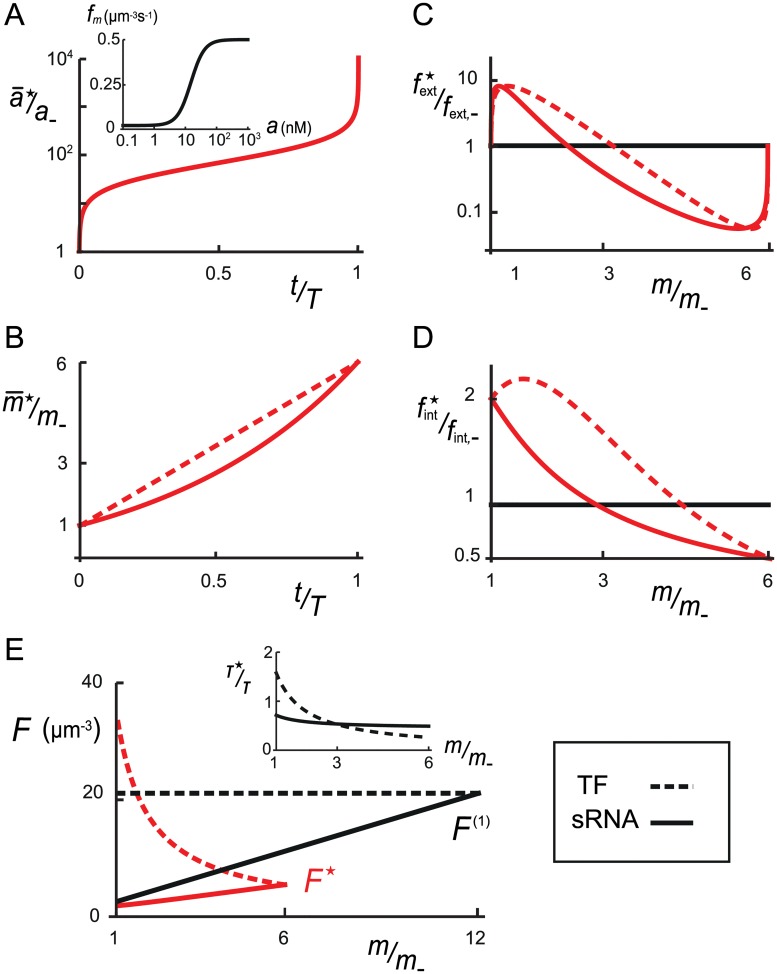
Optimal quorum-sensing response.TF regulation is shown by dashed curves and sRNA regulation by solid curves. A. The bare MP expression rate fm(1)(c), in the absence of self-regulation of the MP, obeys a Hill function with h = 2 (inset). Temporal dynamics of the optimal mean AI concentration and B. temporal dynamics of the optimal mean MP abundance. C. Optimal external feedback fext⋆ with f
− = a
−/(τ
a
ρ
−) and D. optimal internal feedback fint⋆. E. Fano function with optimal feedback F
⋆ and without feedback F as functions of MP abundance m. The ratio of effective correlation times τ
⋆/τ = F
⋆/F is shown inset. In all panels, red curves indicate the optimal quorum-sensing response, black curves indicate the absence of all feedbacks (fext′=0,fint=1). Parameter values: ρ
+/ρ
− = 104, a
− = 0.1nM, a
+ = 1mM, m
− = 100nM, m
+ = 600nM, f
int,− = 2, f
int,+ = 1/2, K = 15nM, h = 2, b = 20 and v = 1μm3.